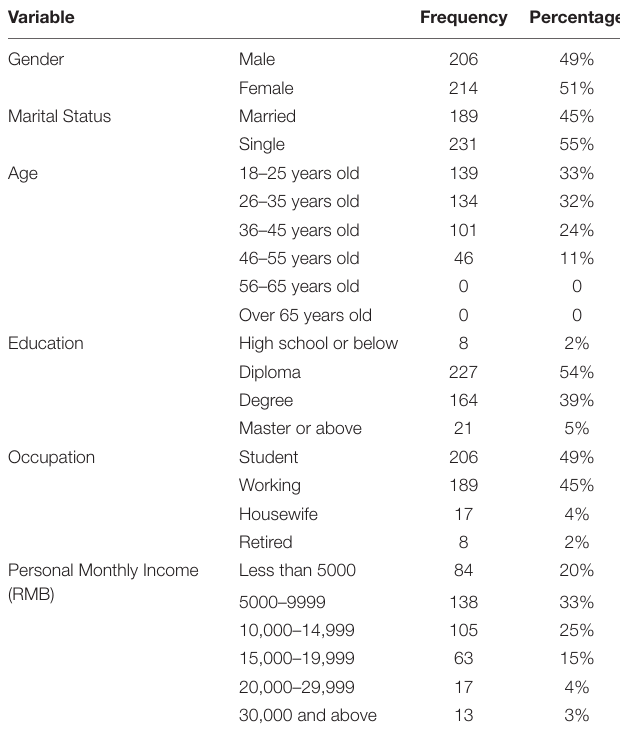
TABLE 1 | Demographic profile of respondents ( N =